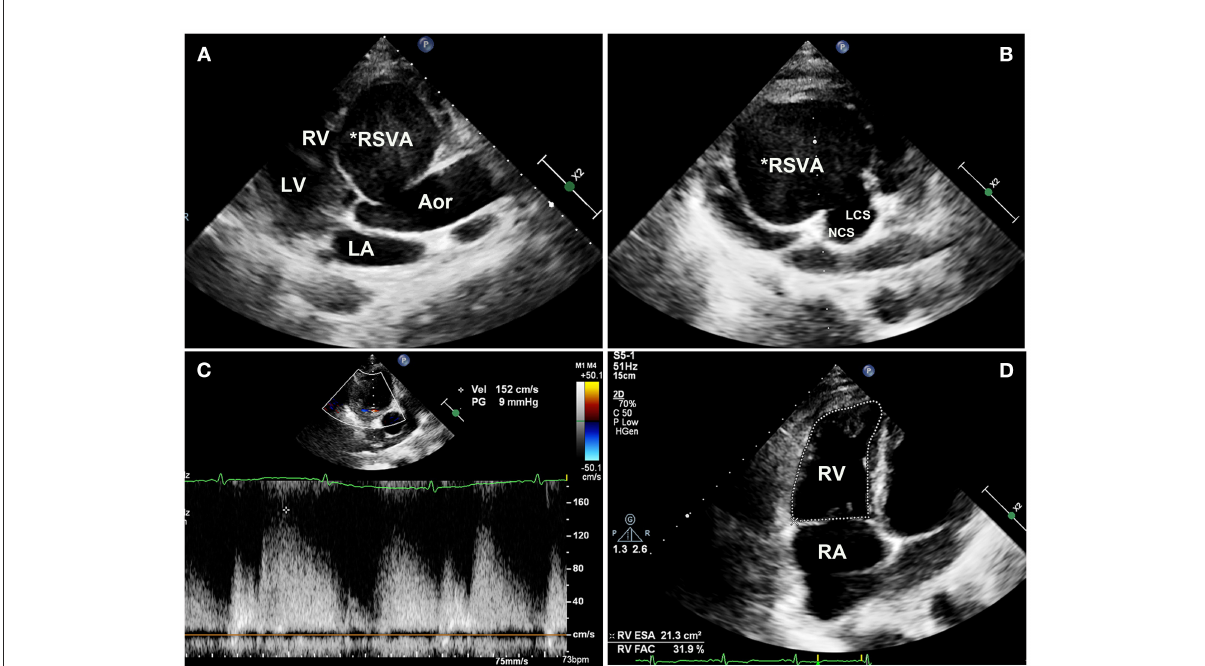
FIGURE2 Transthoracic echocardiography images. (A) Transthoracic echocardiography showing a giant right sinus of Valsalva aneurysm in the long-axis view and (B) the aortic root. (C) The compressed RCA is displaced with an accelerating velocity of 150 cm/s. (D) The right ventricular systolic fraction is reduced (31.9% RVFAC). RSVA, right sinus of Valsalva aneurysm; RV, right ventricle; LV, left ventricle; LA, left atrium; Aor, aorta; NCS, noncoronary sinus; LCS, left coronary sinus; RA, right atrium; RVFAC, right ventricular fractional area